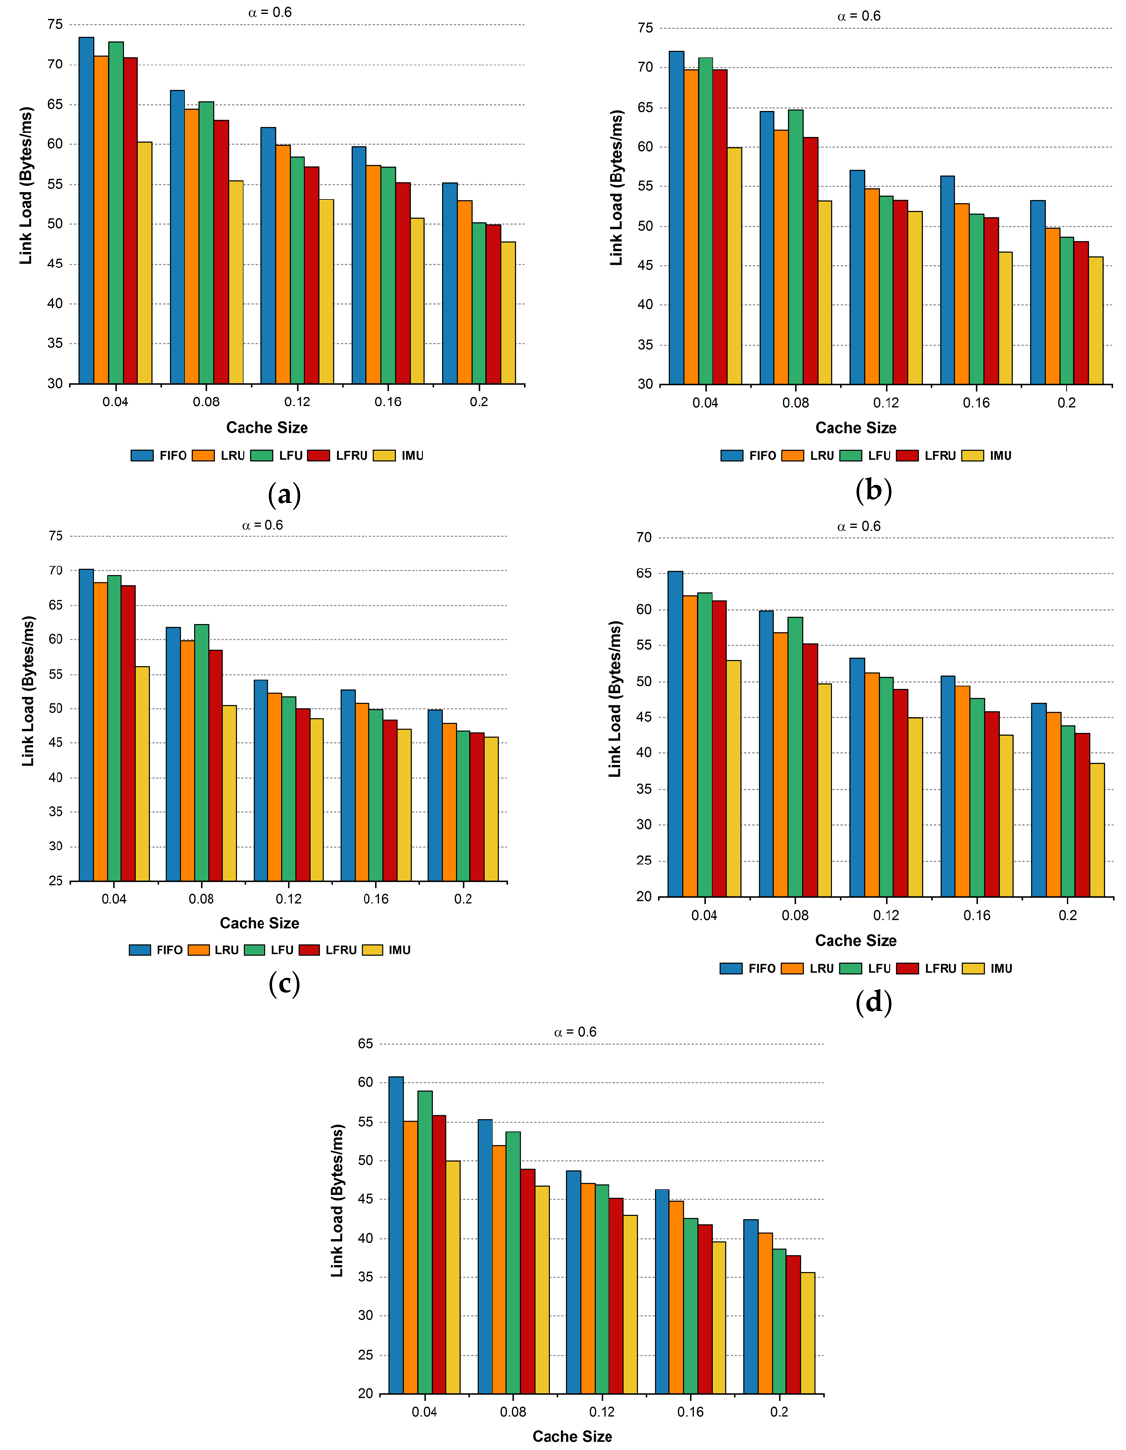
Figure 5. Link load with different cache sizes and α , using different placement policies. ( a ) Link load with LCE. ( b ) Link load with CL4M. ( c ) Link load with ProbCache. ( d ) Link load with LCD. ( e ) Link load with opt-Cache.